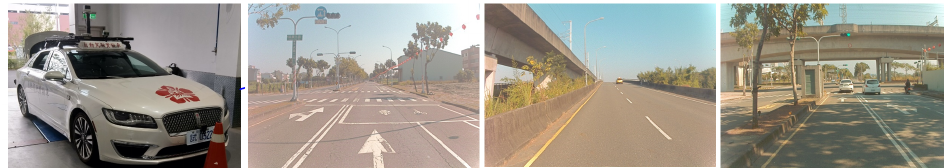
Figure 6. The real dataset of the Lincoln self-driving